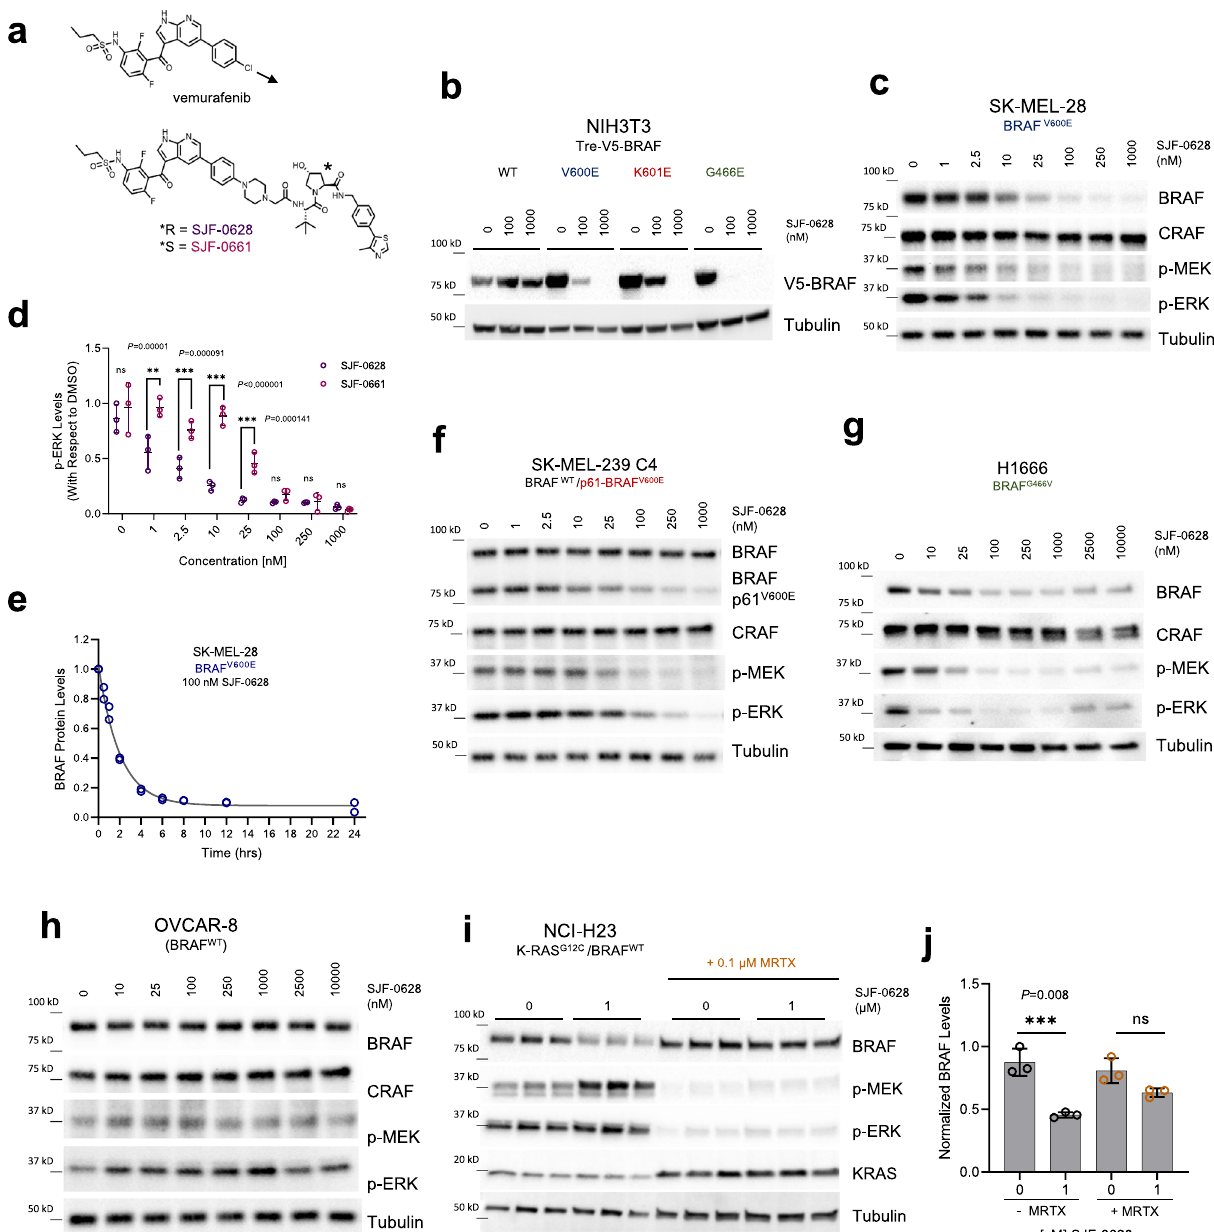
Fig. 1 Vemurafenib-based PROTAC SJF-0628 induces degradation of mutant BRAF. a Chemical structure of vemurafenib and BRAF targeting PROTAC, SJF-0628, and its epimer, SJF-0661. SJF-0628 is composed of vemurafenib, a short piperazine-based linker, and a VHL recruiting ligand. SJF-0661 has an identical warhead and linker as SJF-0628 but contains an inverted hydroxyl group in the VHL ligand and is therefore unable to engage VHL to induce ubiquitination. b Inducible NIH3T3 cells expressing indicated V5-BRAF constructs (doxycycline 100 – 200 ng/mL, 24 h) treated with increasing amounts of SJF-0628. c SK-MEL-28 cells (homozygous BRAF V600E ) treated with indicated amounts of SJF-0628 induced BRAF degradation and suppression of MEK and ERK phosphorylation. d Quantitation of ERK inhibition in SK-MEL-28 cells treated with SJF-0628 or SJF-0661 (mean ± SD, n = 3 biologically independent samples) P value calculated by multiple unpaired t -tests. e Quantitation of SJF-0628 treatment time course (100 nM) at indicated times in SK- MEL-28 cells shows maximal degradation within 4 h ( n = 2 biologically independent samples). f SJF-0628 induces selective degradation of p61-BRAF V600E mutant and inhibits MEK and ERK phosphorylation but spares BRAF WT and CRAF in SK-MEL-239-C4 cells. g H1666 (heterozygous BRAF G466V ) treated with SJF-0628 shows BRAF degradation, but incomplete suppression of ERK signaling. h BRAF WT is spared by SJF-0628 in OVCAR-8 cells but induces slight activation of ERK phosphorylation. i Covalent inhibition of KRAS G12C by MRTX849 in H23 cells hinders PROTAC induced BRAF WT degradation ( n = 3 biologically independent samples). j Quanti fi cation of 1i (mean ± SD, n = 3 biologically independent samples). P value calculated by one-way ANOVA. Source data are provided as a Source Data fi and concomitant inhibition of ERK phosphorylation while CRAF is slightly stabilized (Supplementary Fig. 3c). BRAF-p61 V600E (Supplementary Fig. 3a, b). In SK-MEL-246 cancer cells 40 (Class 2, BRAF G469A ), SJF-0628 induced dose- Class 3 BRAF mutants are kinase dead or hypoactive and are dependent degradation of BRAF (DC 50 = 15 nM, D MAX > 95%) frequently observed in NSCLC 15,41 . Unlike inhibitors, PROTACs